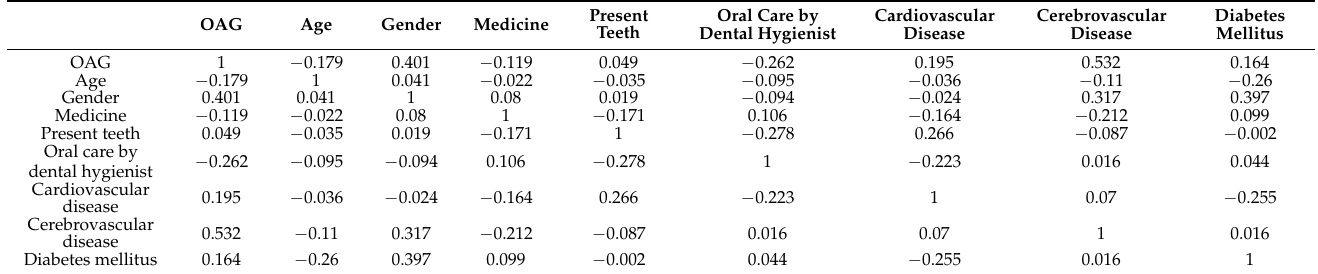
Table 3. Correlation matrix.